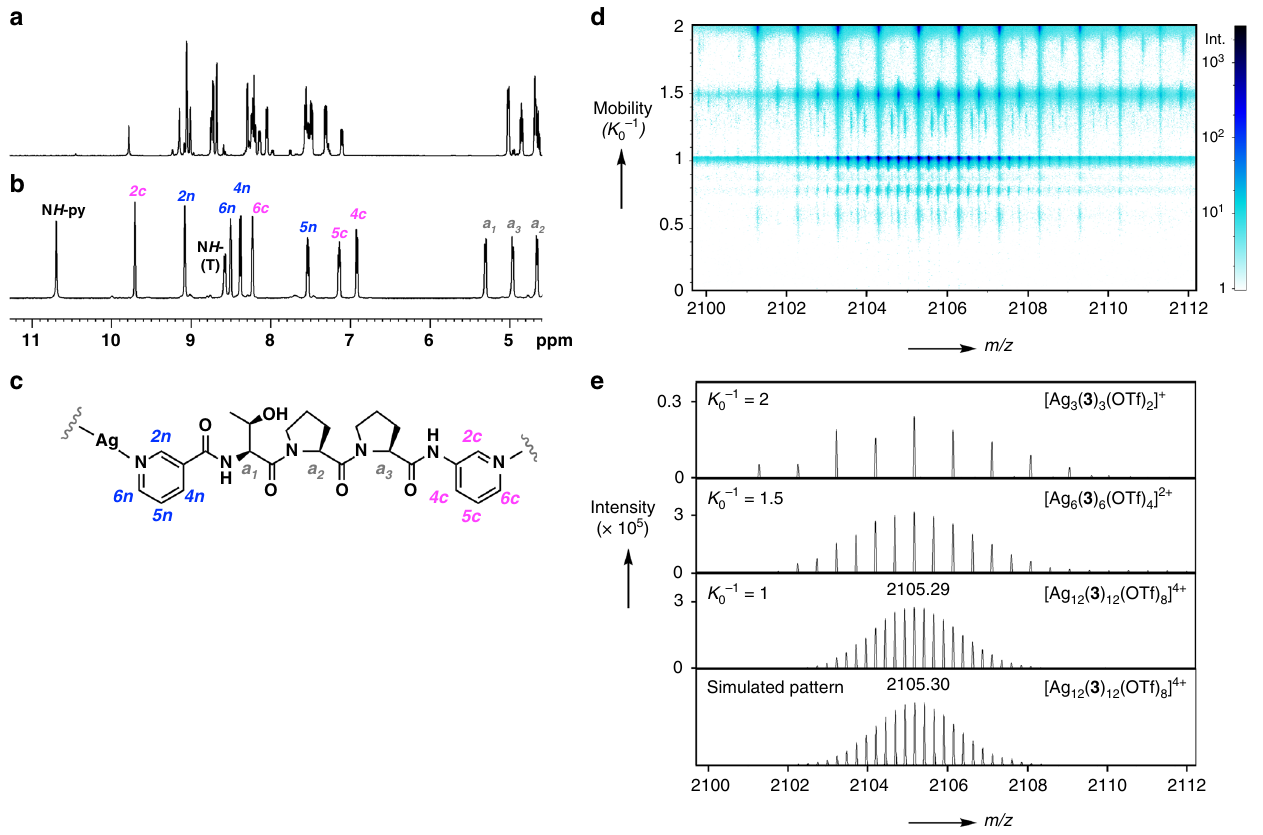
Fig. 3 1 H NMR and ion mobility mass spectrometry data of [4] 12 -catenane 4 . a Partial 1 H NMR spectrum of ligand 3 in CD 3 NO 2 . b Partial 1 H NMR spectrum of [4] 12 -catenane 4 in CD 3 NO 2 (300 K, [ 3 ] = 50 mM). c Chemical structure of ligand 3 with proton numbers used for the signal assignments in b . d Mobility vs. m / z plot obtained from ion mobility mass spectrometry of 4 . e Mass spectra at K 0 − 1 = 2, K 0 − 1 = 1.5, K 0 − 1 = 1, and simulated pattern of [Ag 12 ( 3 ) 12 (OTf) 8 ] 4 + from the top